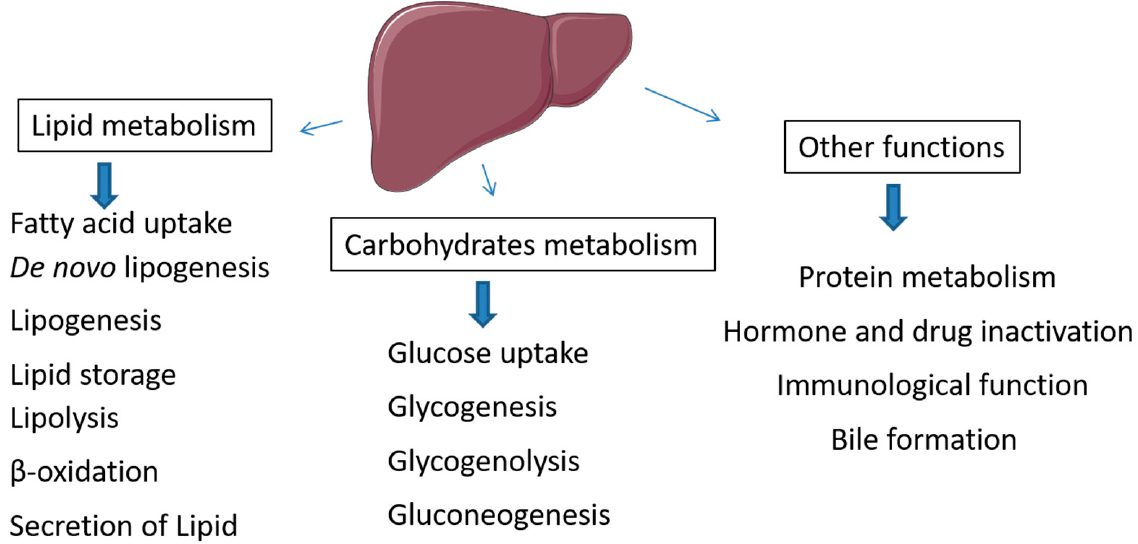
Figure 3. Metabolic role of liver in lipid and carbohydrate metabolism. Liver plays key role in regulation of metabolic processes of lipogenesis, lipolysis, lipid secretion, glycogenesis, glycogenolysis and gluconeogenesis.